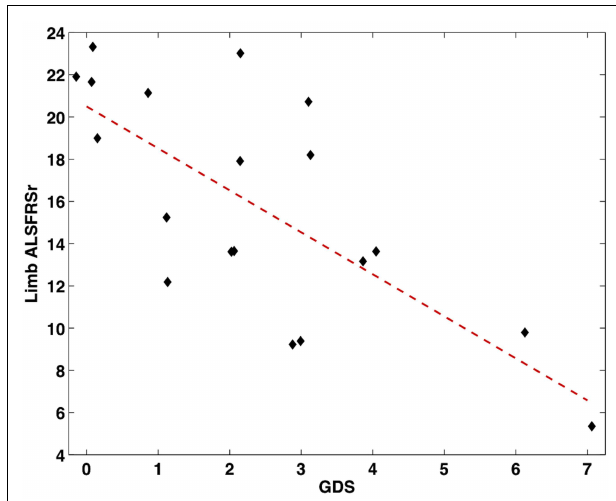
FIGURE 2 | Scatter plot showing the significant correlation between increased depressive scores from the GDS and decreased limb function measured from theALSFRS-r ( n =